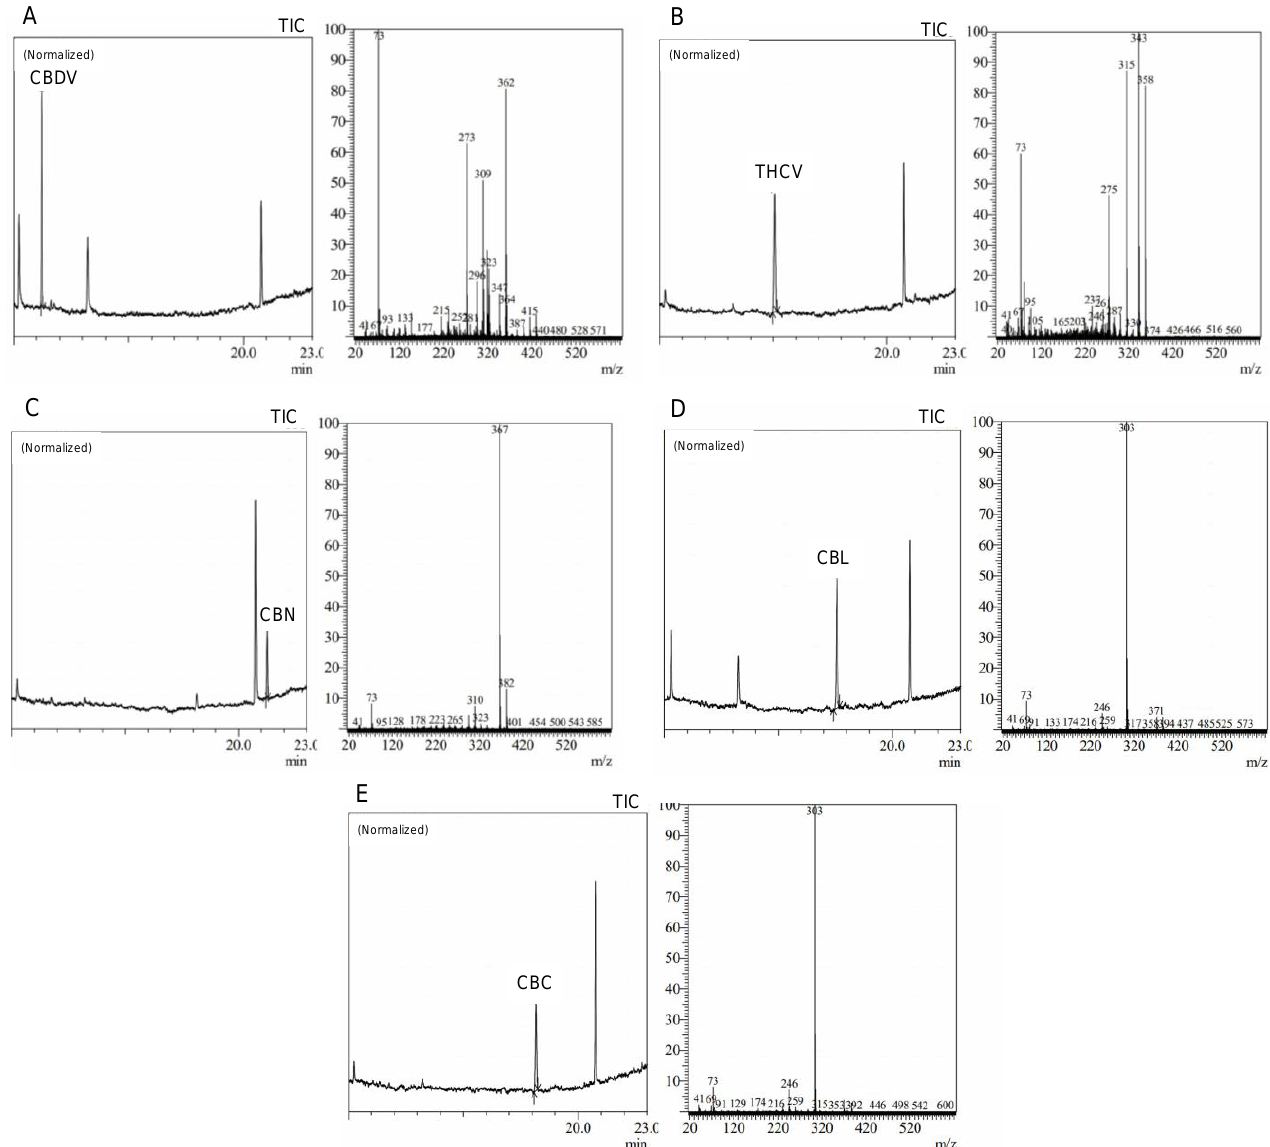
Figure 2. Average peak chromatograms and mass spectra of ( A ) cannabidivarin (CBDV), ( B ) tet-rahydrocannabivarin (THCV), ( C ) cannabinol (CBN), ( D ) cannabiciclol (CBL), and ( E ) canna-bichromene (CBC) derivatized cannabinoid standards.